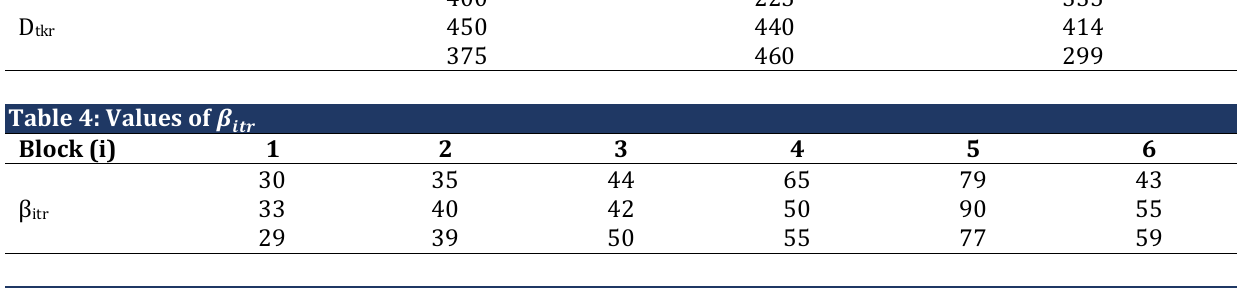
Table 5: Number of initial containers C2 Block (i)